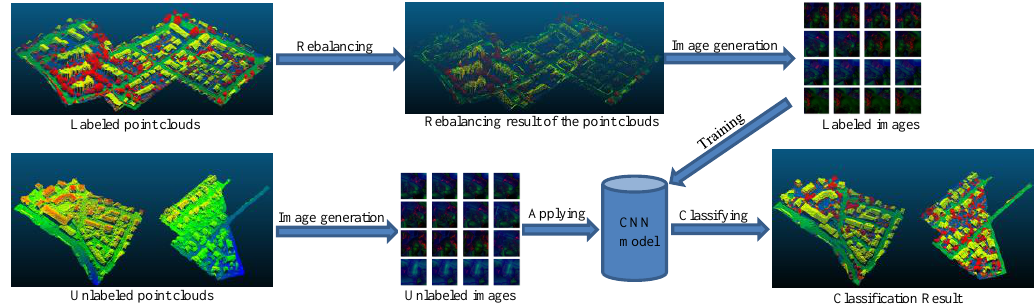
Figure 1. The workflow of the proposed method.